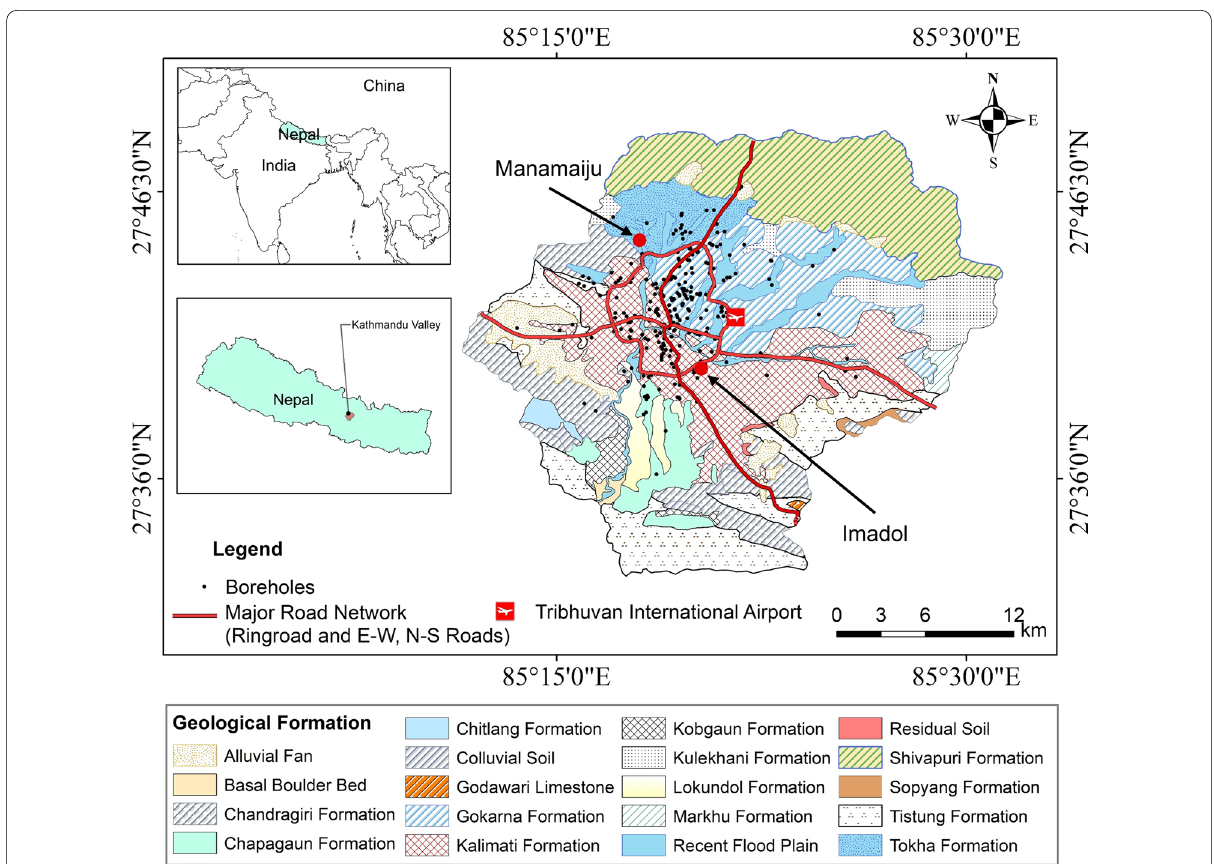
Fig. 1 Kathmandu Valley area and its geological formations (modified after Dhital 2015) together with the locations of the boreholes used in the study and locations of Manamaiju and Imadol where liquefaction was manifested during the 2015 Gorkha Earthquake (refer Fig.